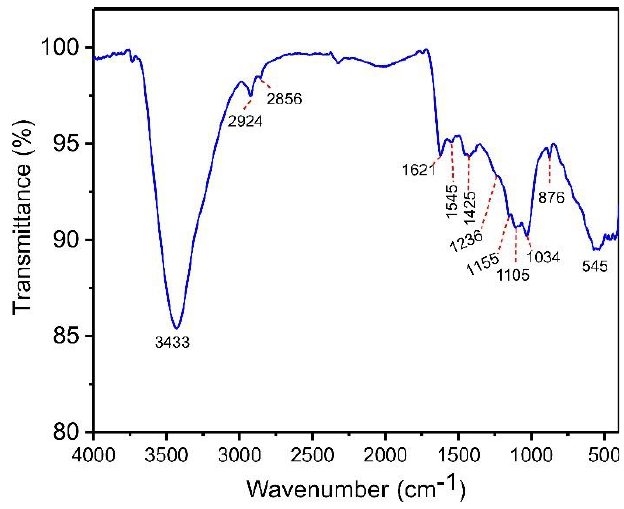
Figure 3. FTIR spectra of ABC biochar.